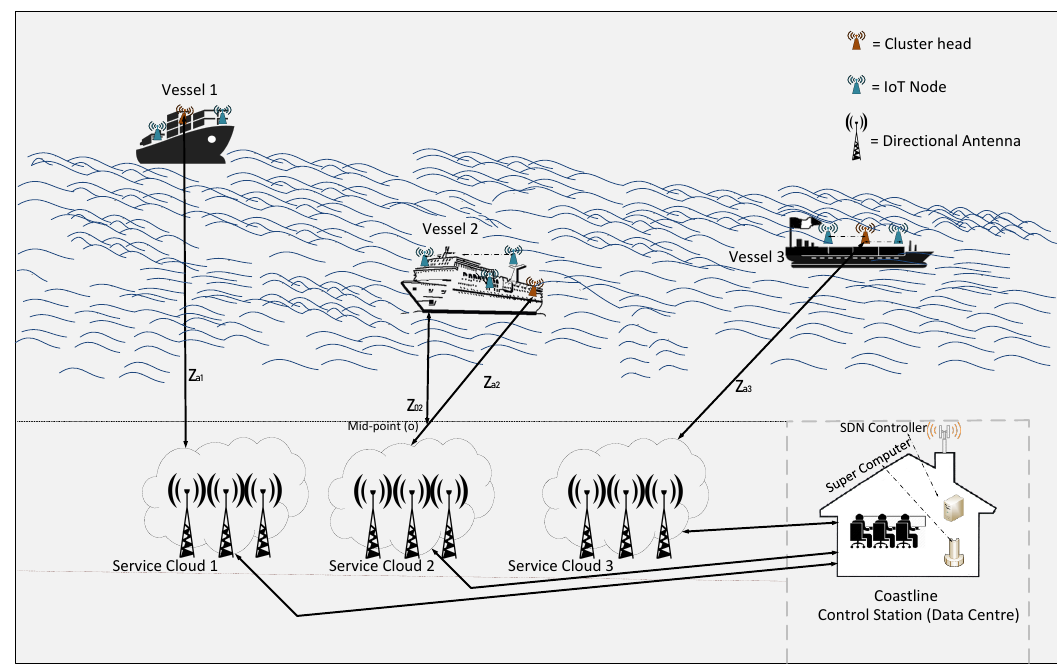
Figure 2. Sensor-based communication architecture for maritime